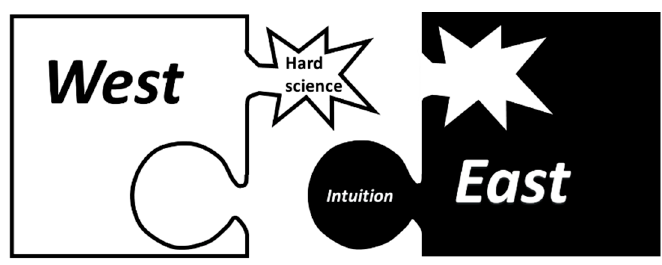
Figure 4. We should connect West and East to obtain a more complete picture.